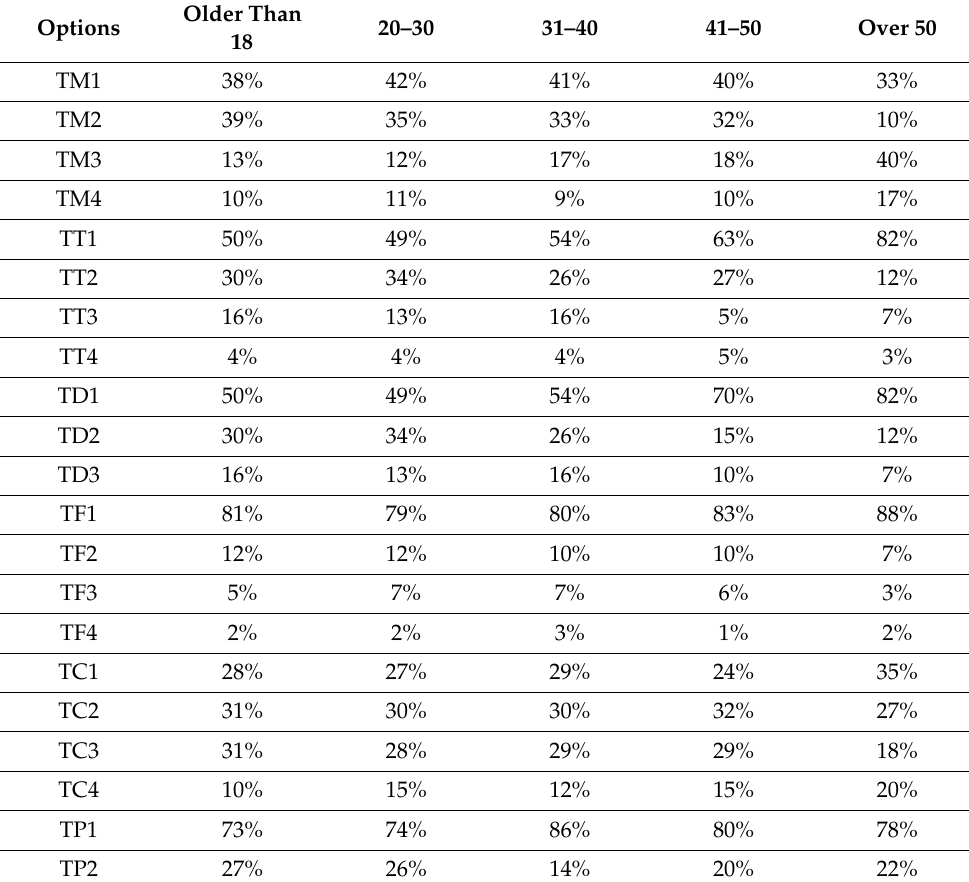
Table 4. Priorities of TBCs from the lens of age